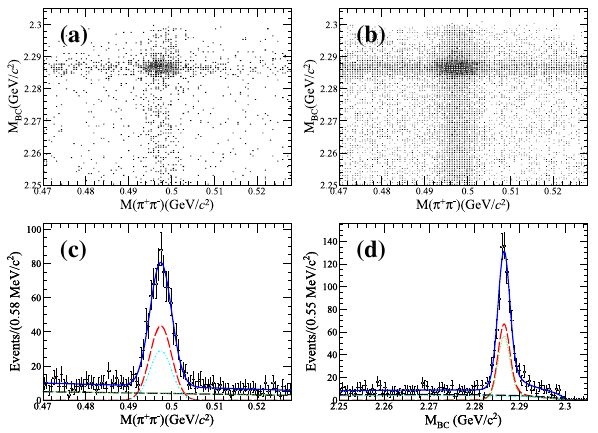
Fig. 2 a , b Distributions and c and d projections of M BC versus M (π + π − ) of the DT candidate in a data and b the 2D fit result, where the black dots with error bars are data, the blue solid curves are the fit results, the red-dashed lines are signal function, the black-dashed lines are background neither peaking in the M (π + π − ) distribution nor the M BC distribution, the green-dotted lines are background peaking around the ¯ (cid:2) − c mass in the M BC distribution, and the cyan-dash-dotted lines are background peaking around the K 0 mass in the M (π + π − ) S distribution